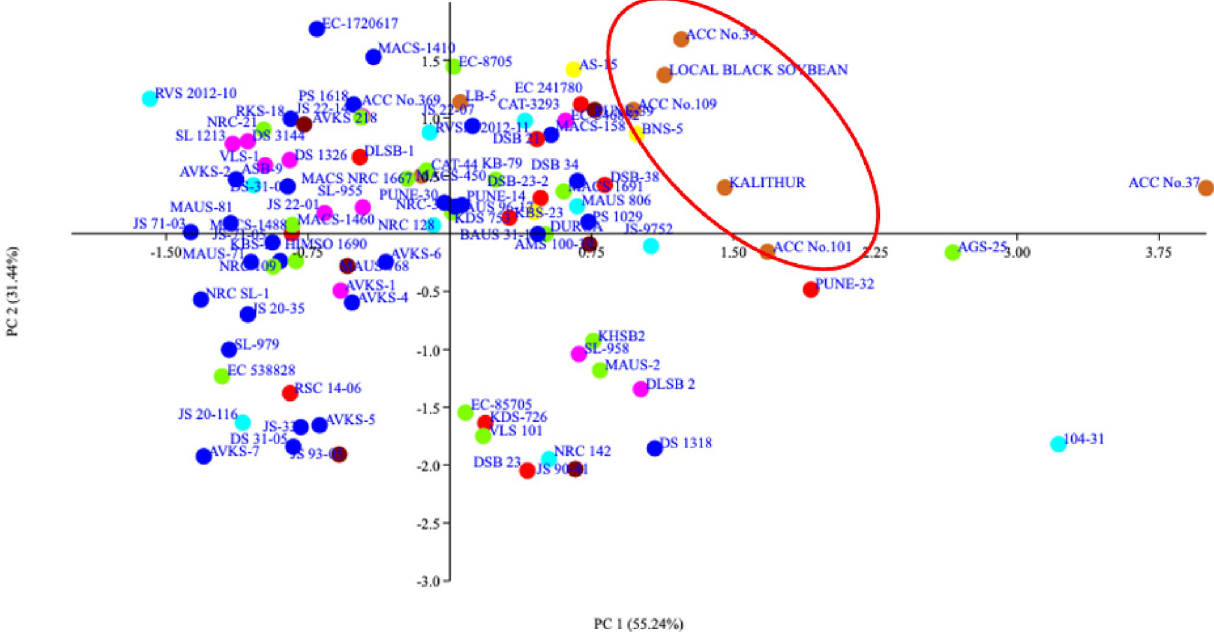
Fig 10. Scatter plot of genotypes based on eigenvalues of components in PC 1 and PC 2. (First quadrant: genotypes with high seed longevity, tall plant height and small seed size (circle consists of black seed coat colour genotypes from C7 sub-population of STRUCTURE analysis using SNP markers); Second quadrant: genotypes with high seed longevity, short plant height and small seed size; Third quadrant: genotypes with low seed longevity, short plant height and bigger seed size; Forth quadrant: genotypes with low seed longevity, tall plant height and bigger seed size).